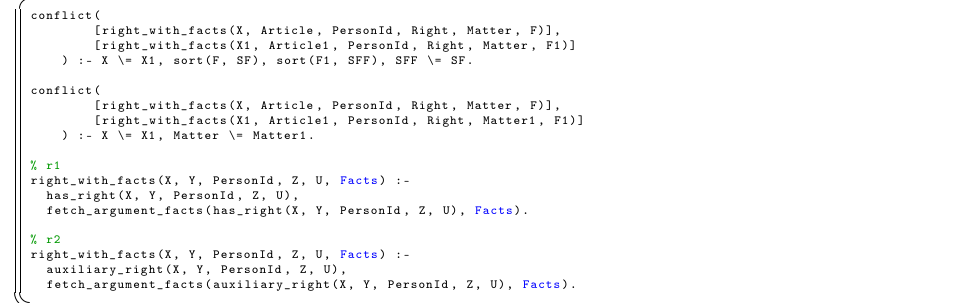
Figure 16. Conflicts added to the Prolog